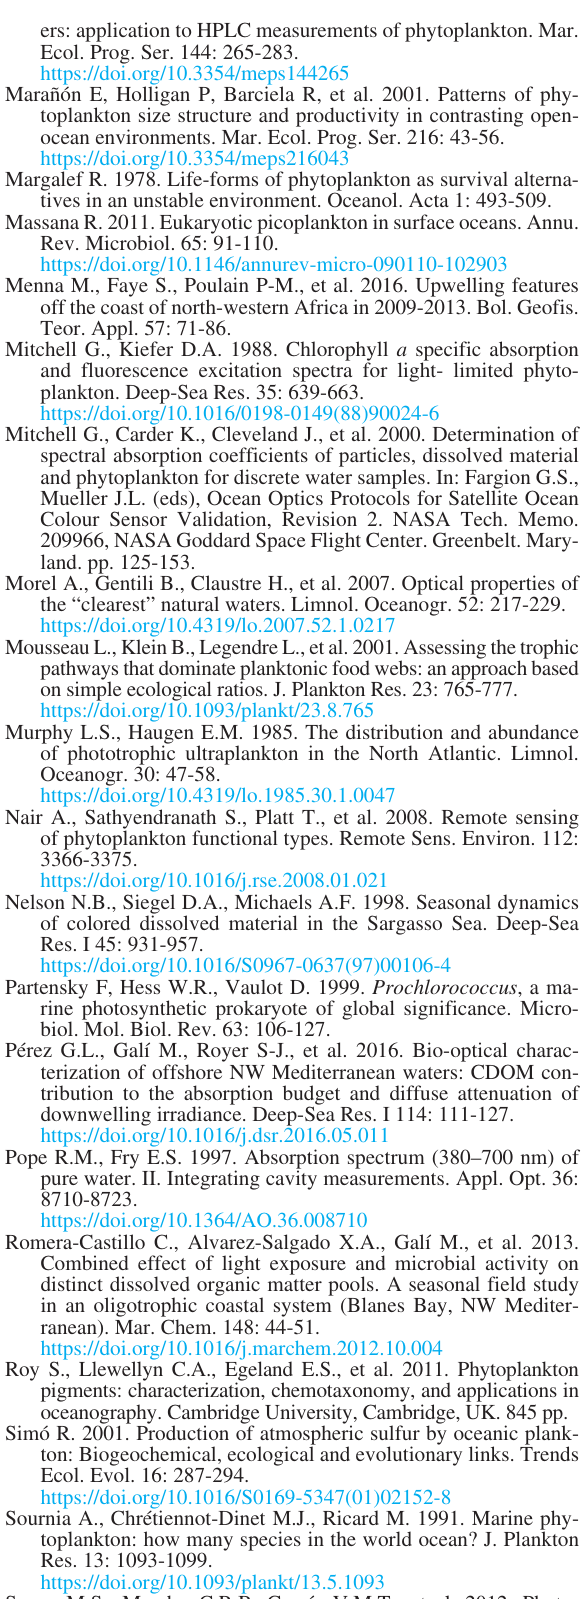
Table S1. – Province allocation, position and sampling date and time of the TransPEGASO stations. Table S2. – Pigment ratios used for the runs of the different CHEMTAX clusters (cluster 1 includes MEFI and SWAS; clus- ter 2, the other provinces). The numbers indicate the amount of pigment per unit of Chl a . See Table 1 for pigment name abbreviations. Table S3. – Range (minimum: Min and maximum: Max), mean